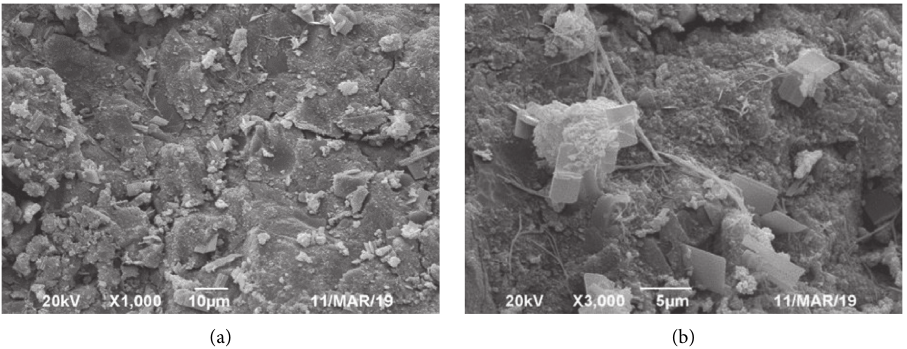
Figure 8: Microstructure of UHPC without LC-NC